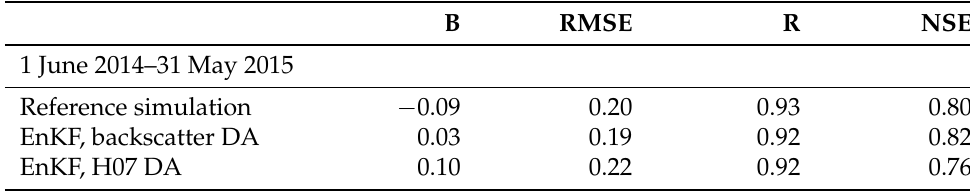
Table 6. Synoptic statistics for streamflow under H07 and backscatter data assimilation, Demer catchment. The unit for bias and RMSE is